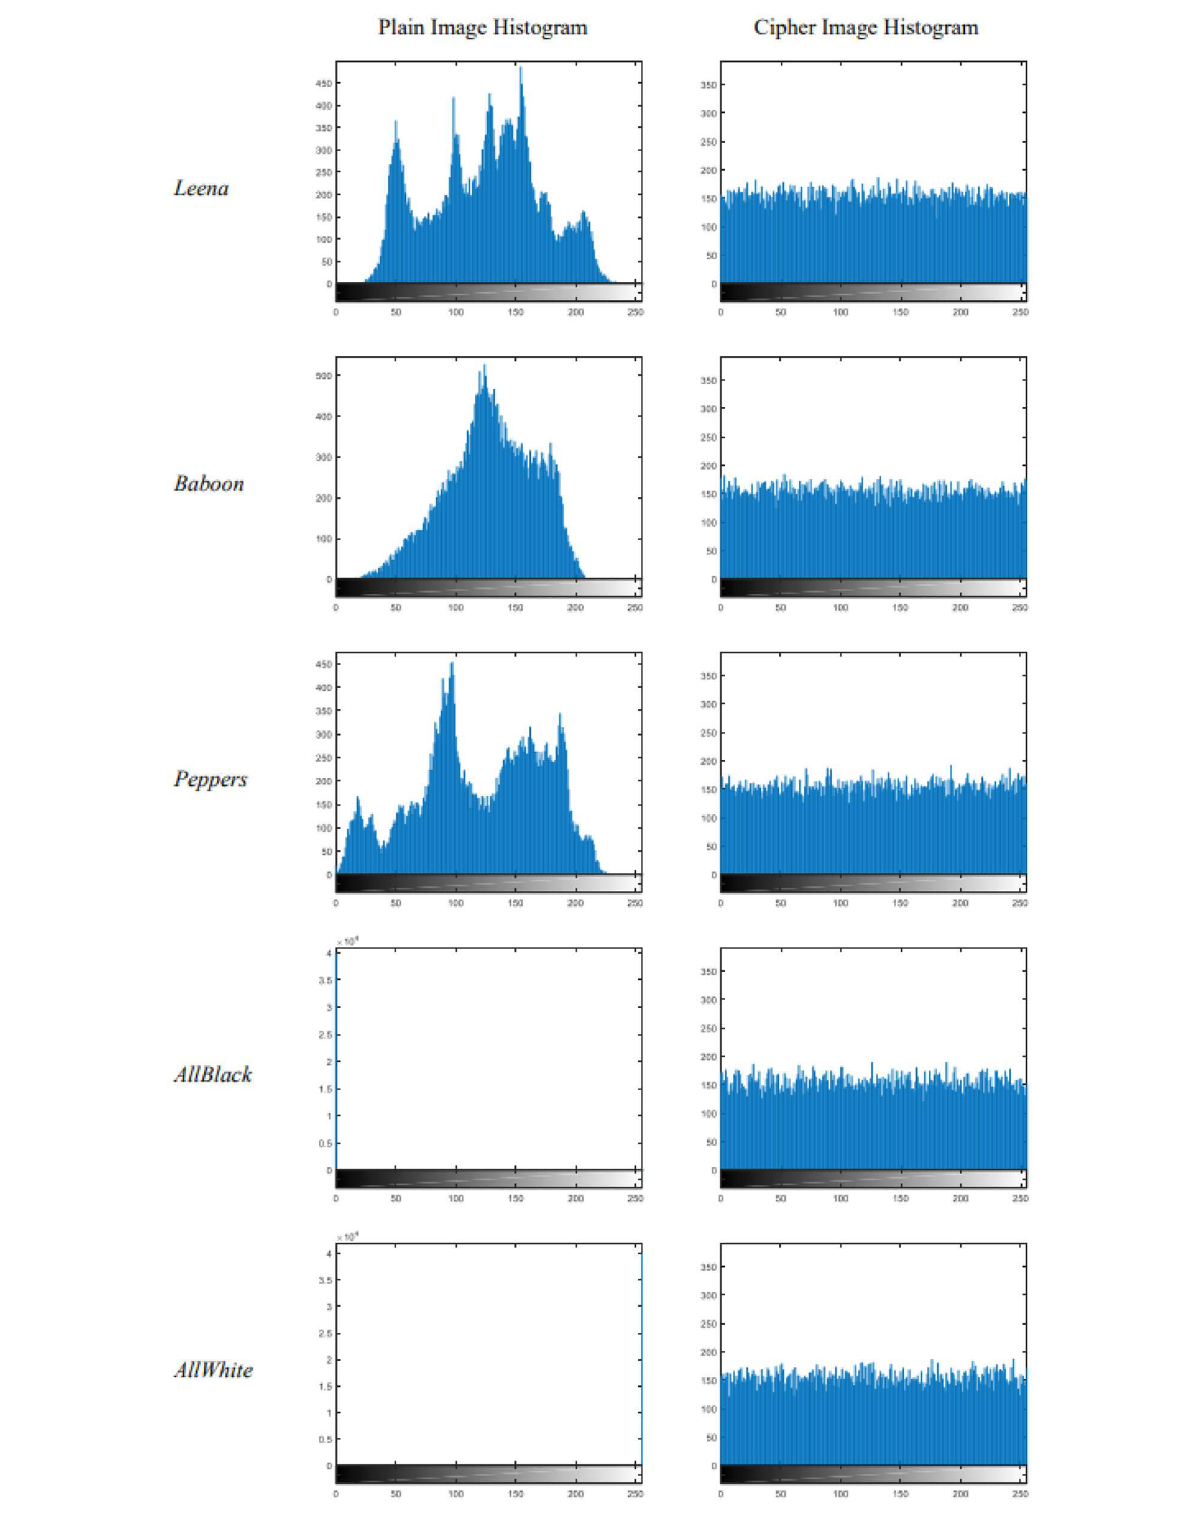
FIGURE5 Histograms of plain images and corresponding cipher